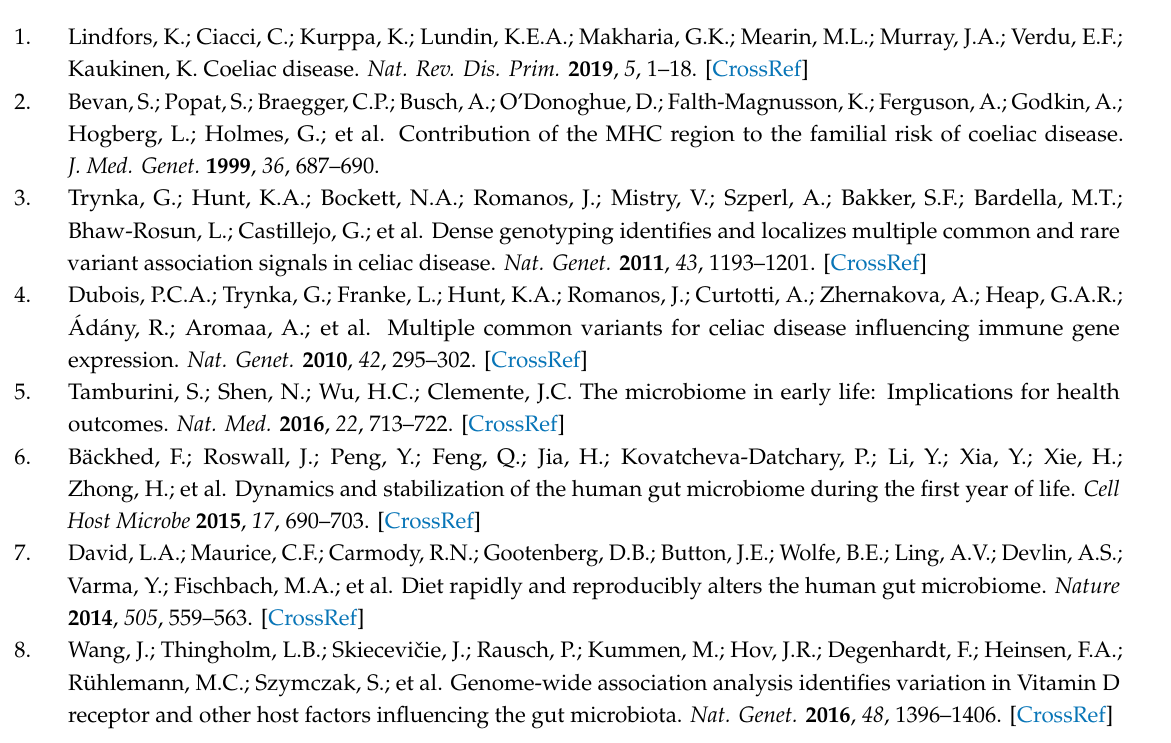
Figure S1: Schematic representation of 2SMR analysis using Bonder microbiome and Trynka CeD GWAS as exposure and outcome datasets,